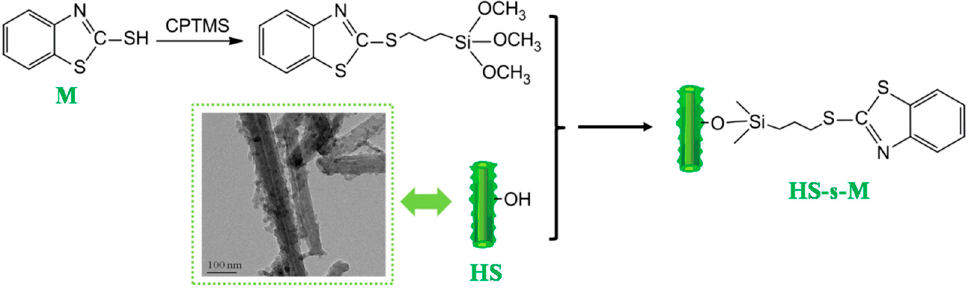
Figure 1. Schematic route of the preparation of HS-s-M.